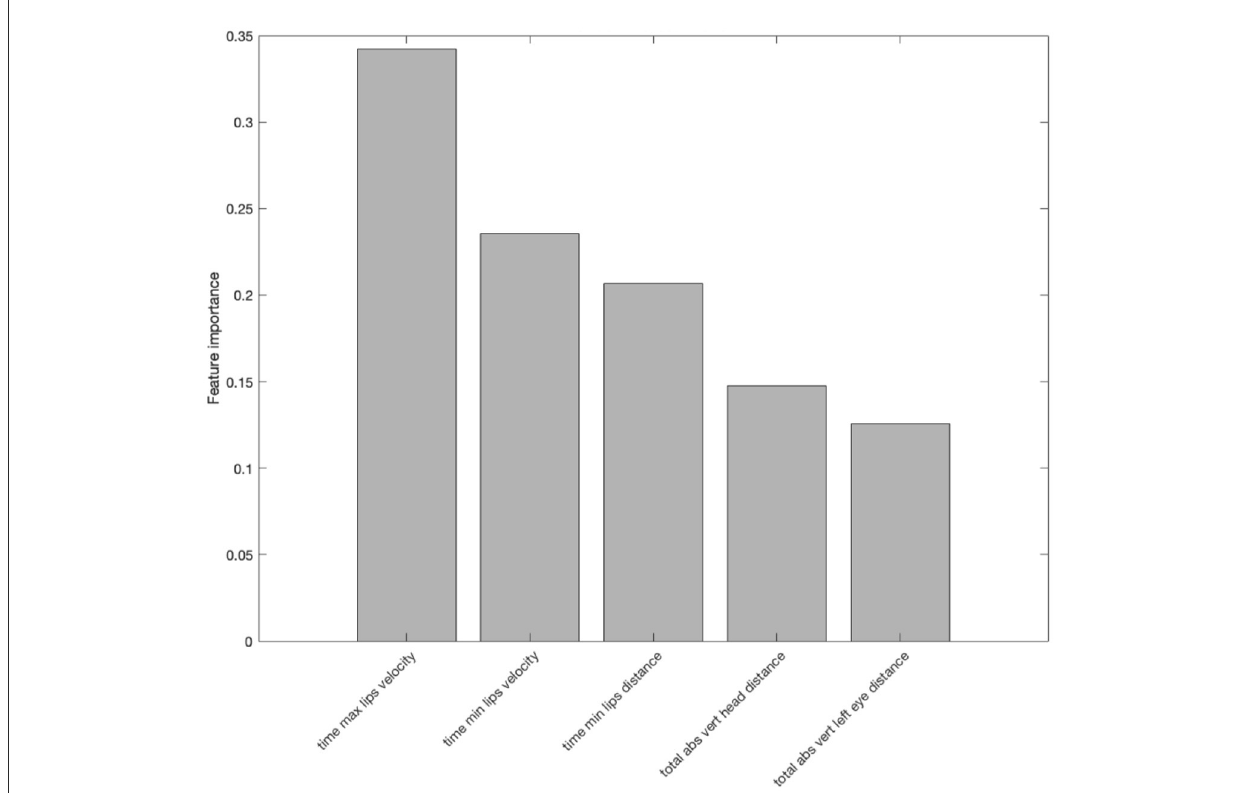
FIGURE6 Important features identified by random forest in differentiating the two speech styles (clear and plain) in Tone 2. The y-axis shows the feature importance measured by the random forest. The feature importance measures the increase in classification error if the values of the feature are permuted. The greater the error the higher the importance of the feature